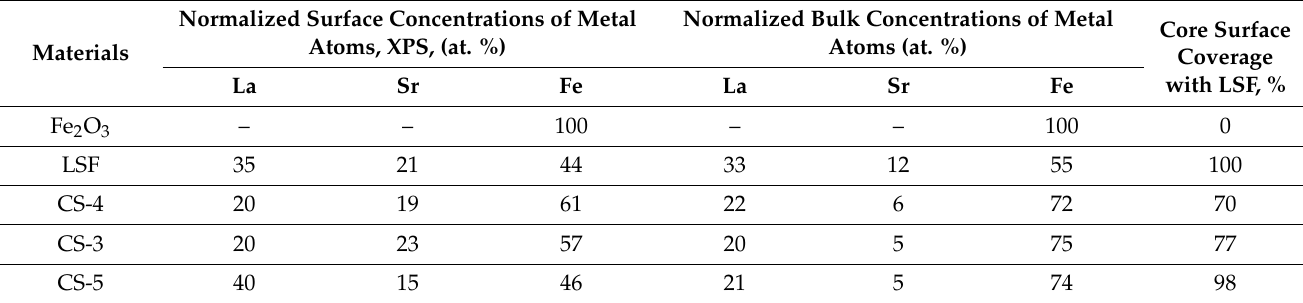
Table 3. Coverage of iron oxide core with LSF shell in synthesized core-shell materials according to XPS data. Normalized Surface Concentrations of Metal Materials